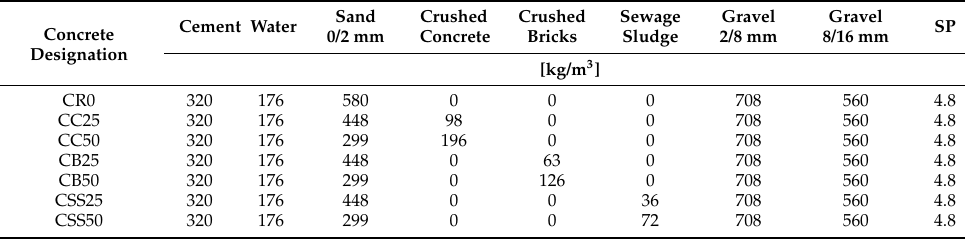
Table 1. The compositions of concrete mixes.